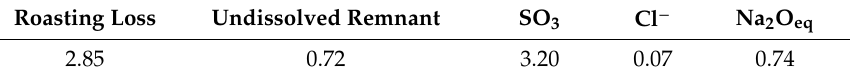
Table 3. Chemical properties of cement CEM I 42.5 R as (%).